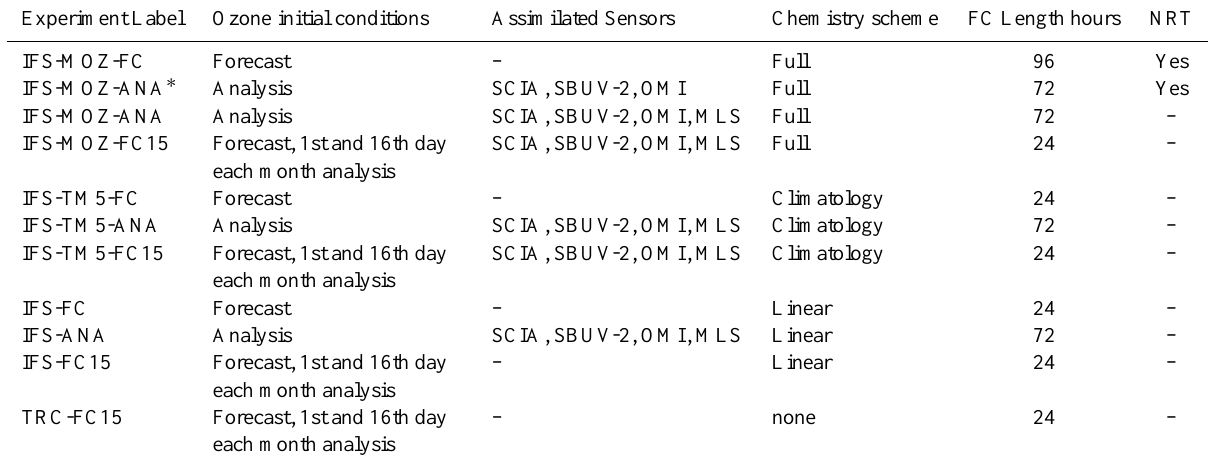
Table 2. List of experiments.